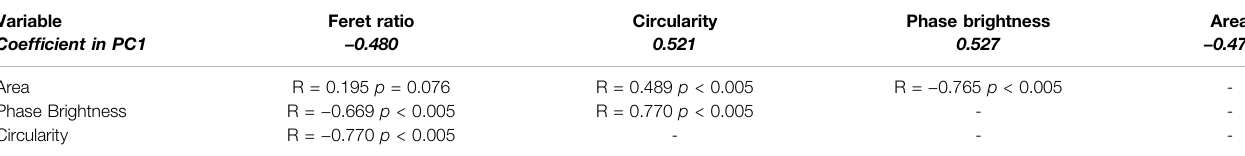
TABLE 4 | Correlations between shape characteristics of cells cultured in serum/LIF medium. Variable Coef fi cient in PC1